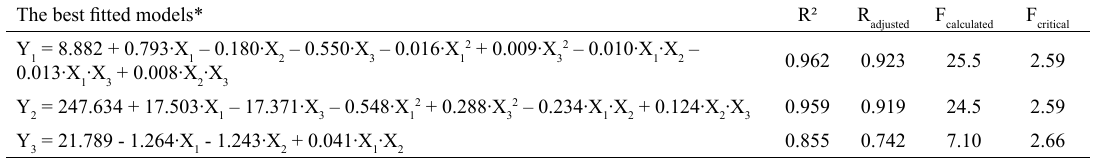
Table 4. Prediction of mechanical properties for the biocomposites by fitting models with the obtained data. The best fitted models*